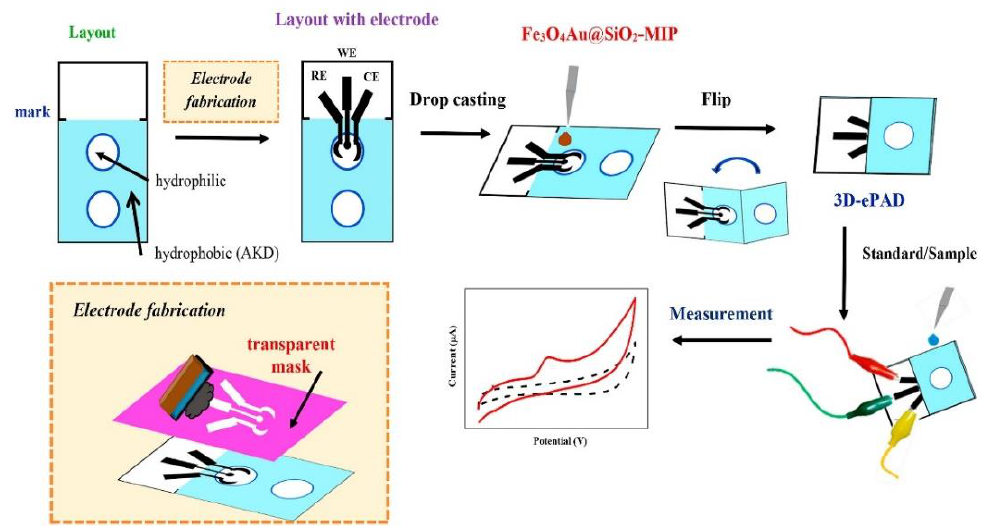
Figure 5. Preparation of Ser sensor and Ser detection using 3D-ePAD. Reproduced with permission from Ref. [74]. Copyright 2019, Elsevier. 3D-ePAD: Three-dimensional electrochemical paper-based analytical device.